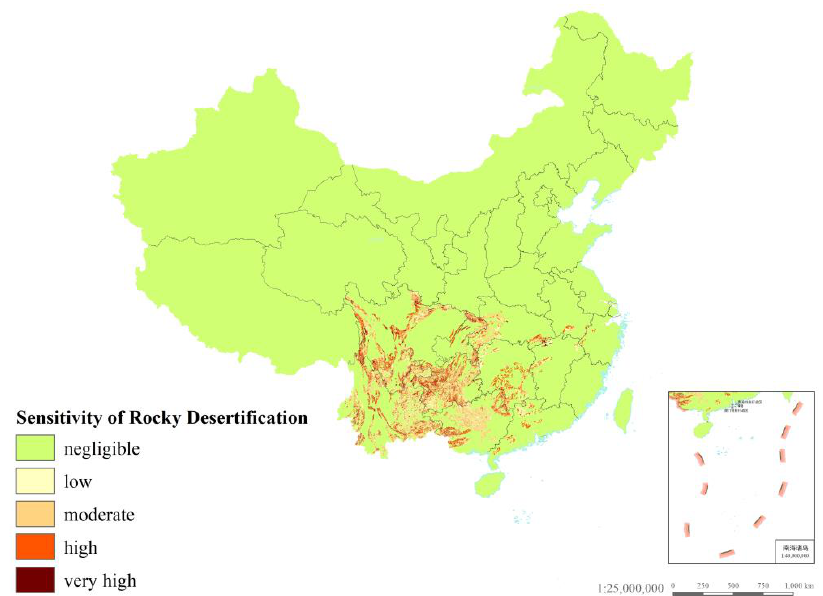
Figure 3. The Grid Map of the Rocky Desertification Sensitivity Index in China.